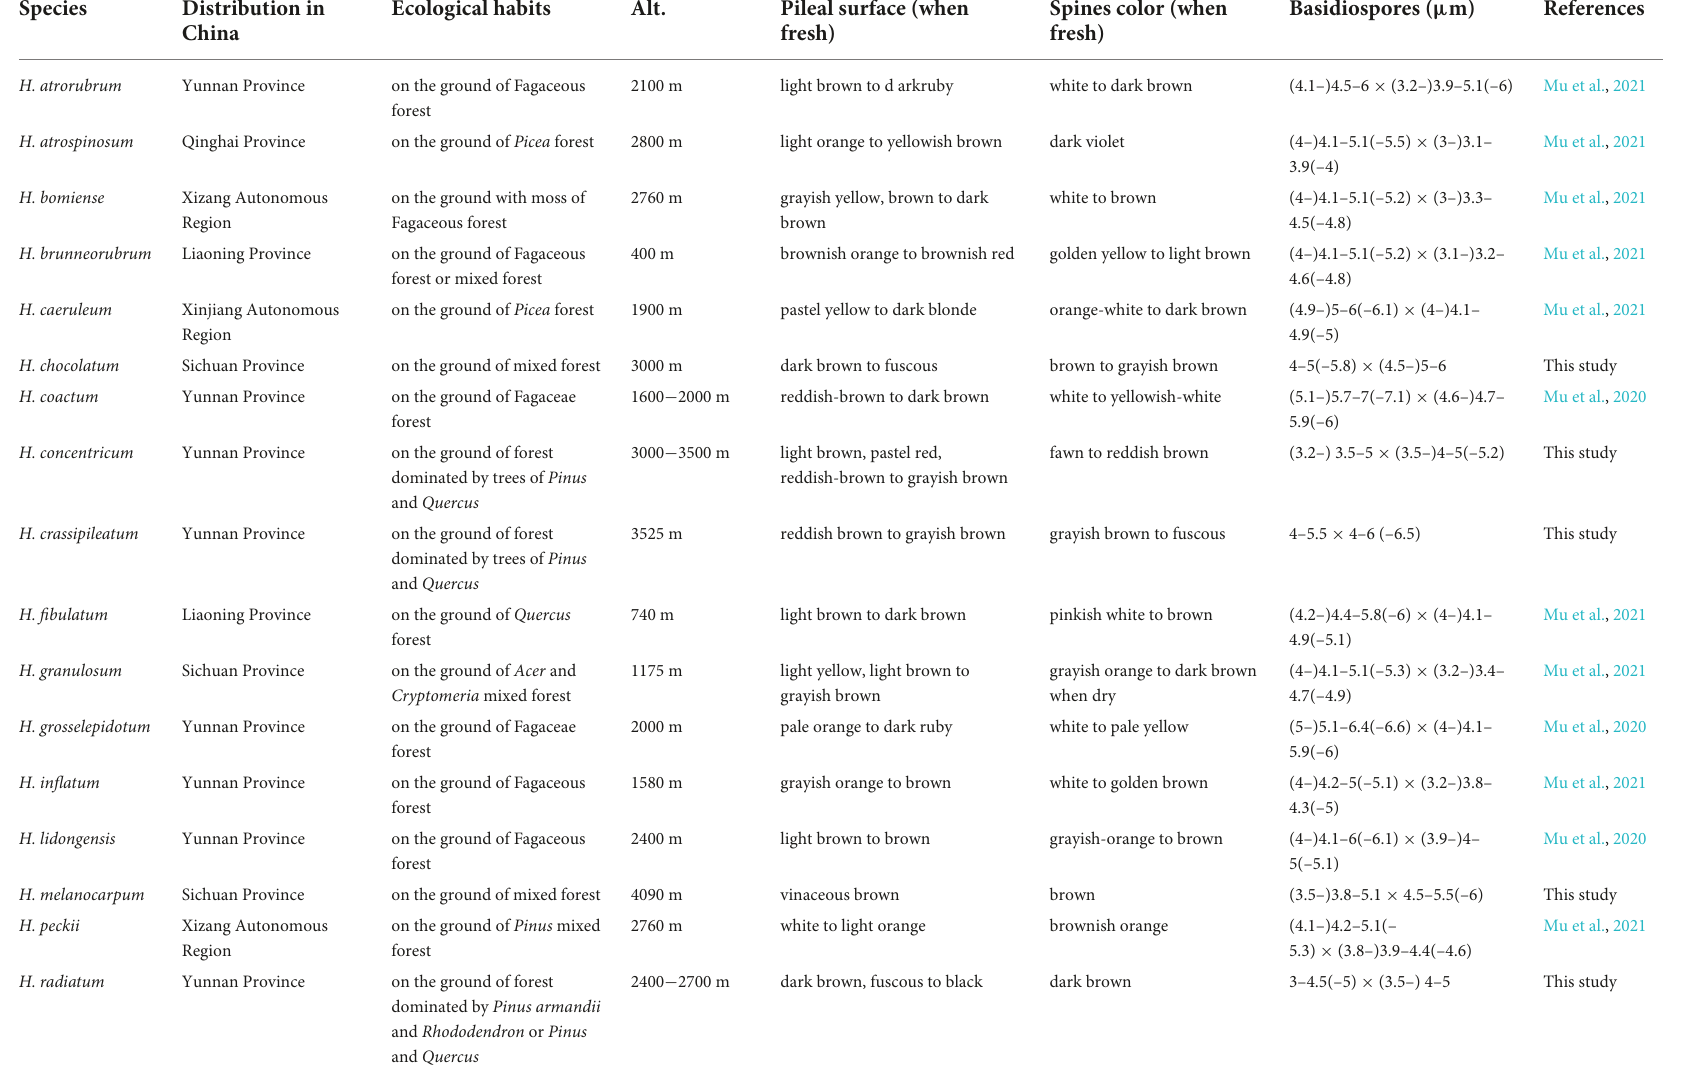
TABLE 2 The distribution areas, ecological habits, and main morphological characters of species in Hydnellum from